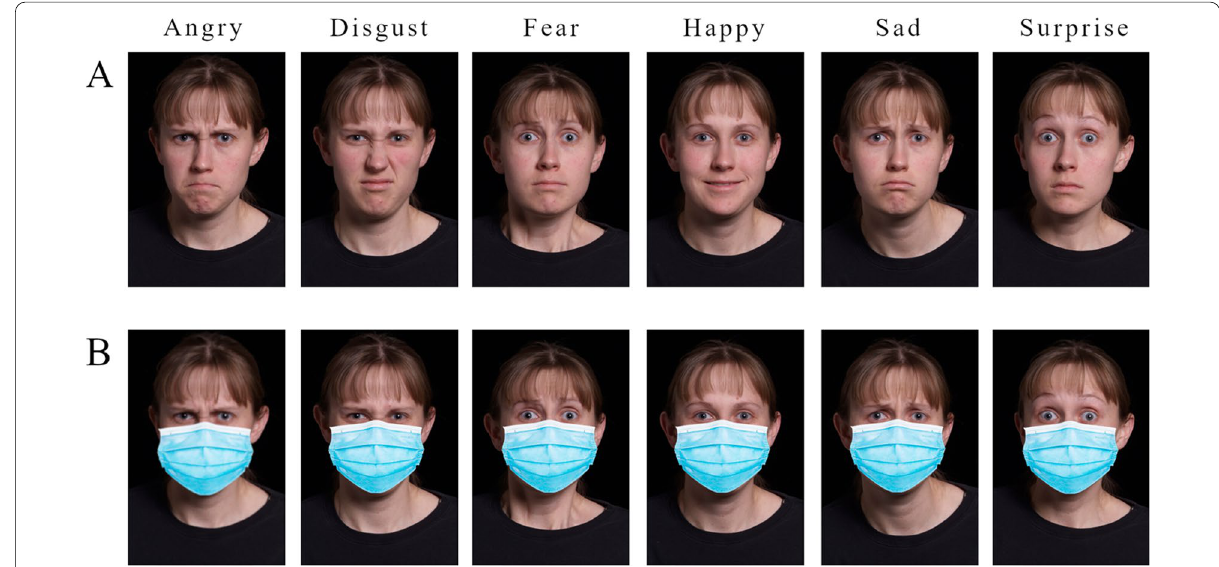
Fig. 1 Sample of images used for masked and unmasked conditions. A A person showing six different emotions without a mask. B The same person showing six different emotions with a